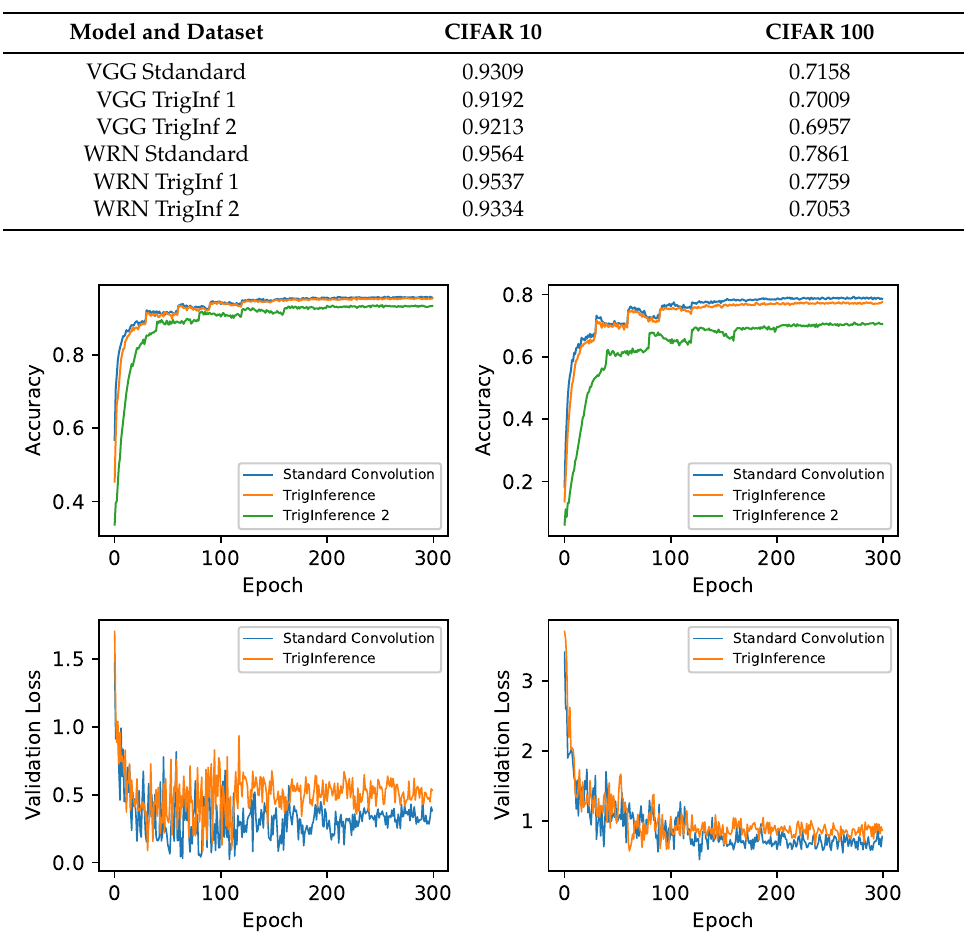
Figure 5. Training curves of WideResNet on CIFAR-10 and CIFAR-100. The left subplots denote the validation accuracy and loss records on CIFAR-10 and the right subplots denote those on